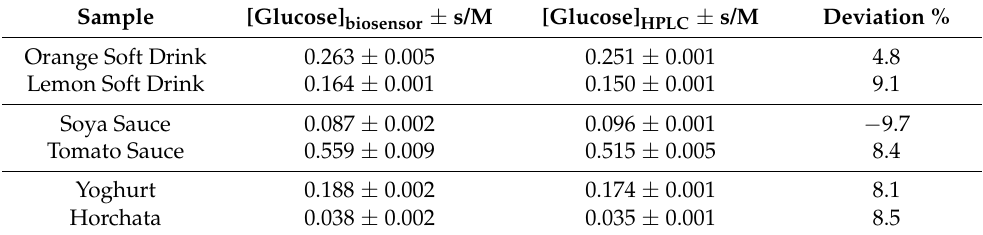
Table 7. Glucose concentration values obtained using the Ti/TiO 2 NTAs/ppHEMA-co- EGDA/pgPFM/GOx/Chitosan biosensor and HPLC values. Standard deviation (s) and deviation of both methods are also